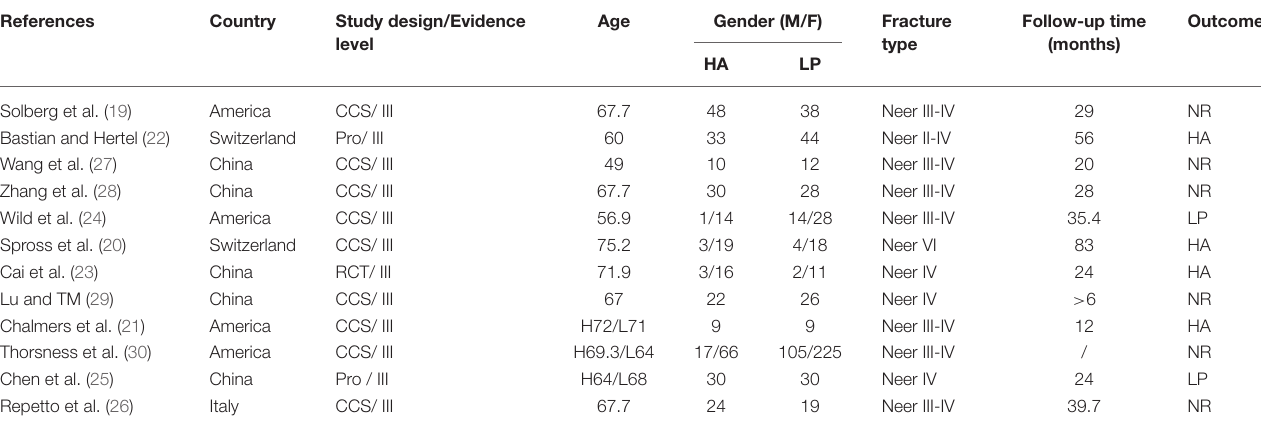
TABLE 1 | Characteristics of the included studies.